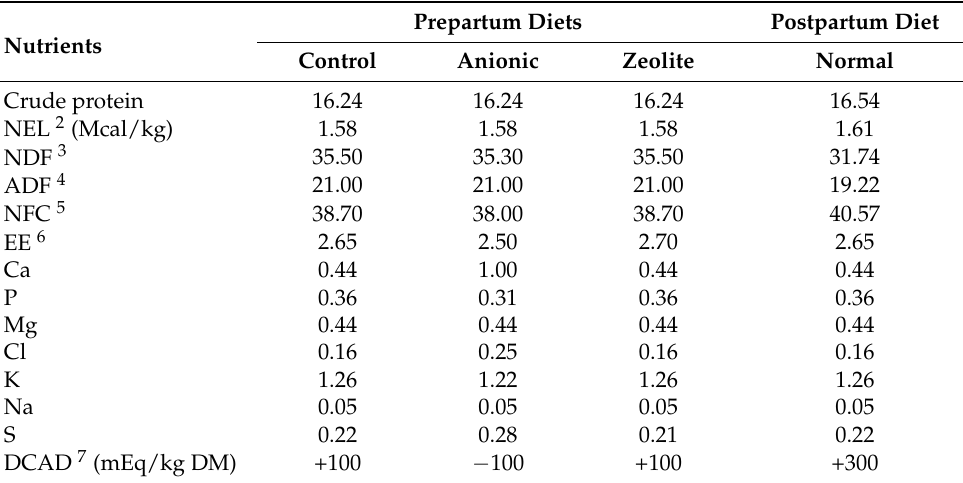
Table 2. Chemical composition of the experimental diets before and after parturition (% of DM unless otherwise noted) 1